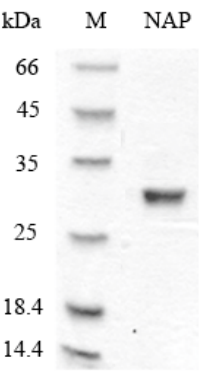
Figure 1. SDS-PAGE analyses of purified NAP. M: protein marker; NAP: purified NAP.